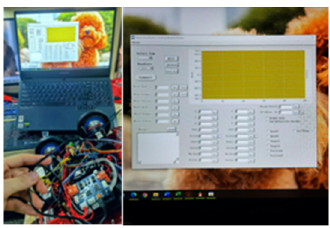
Figure 14. Connection and debugging.